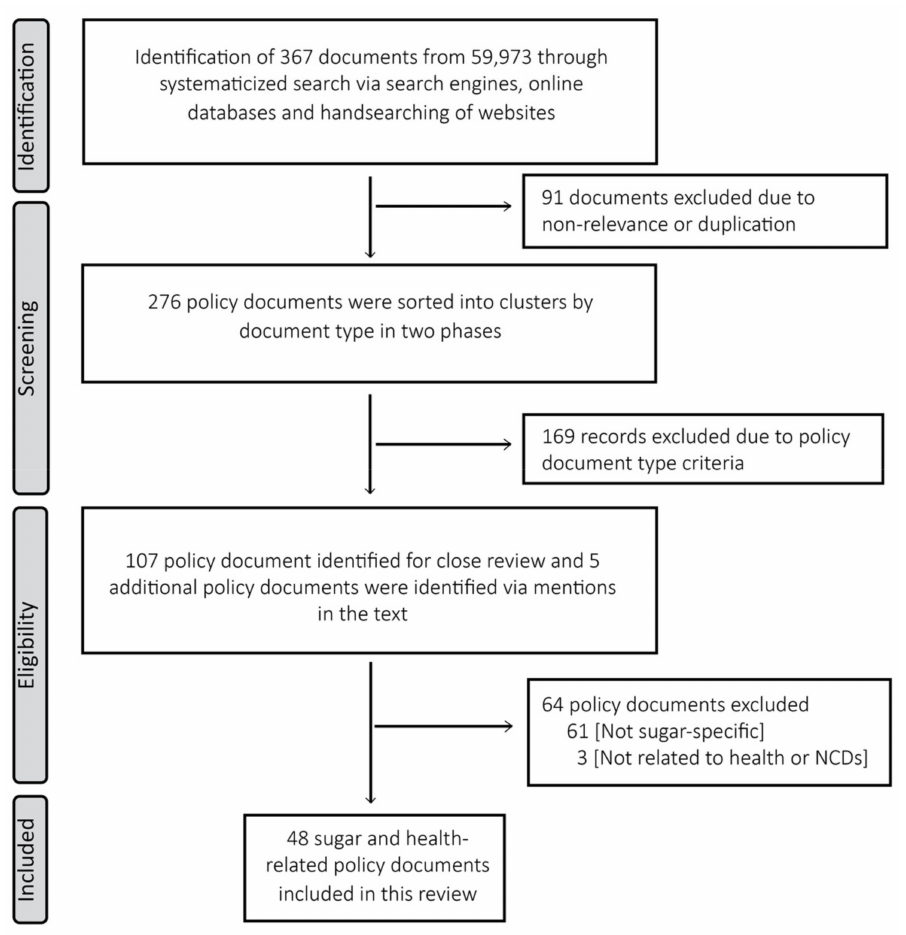
Figure 1. Article selection flow chart.